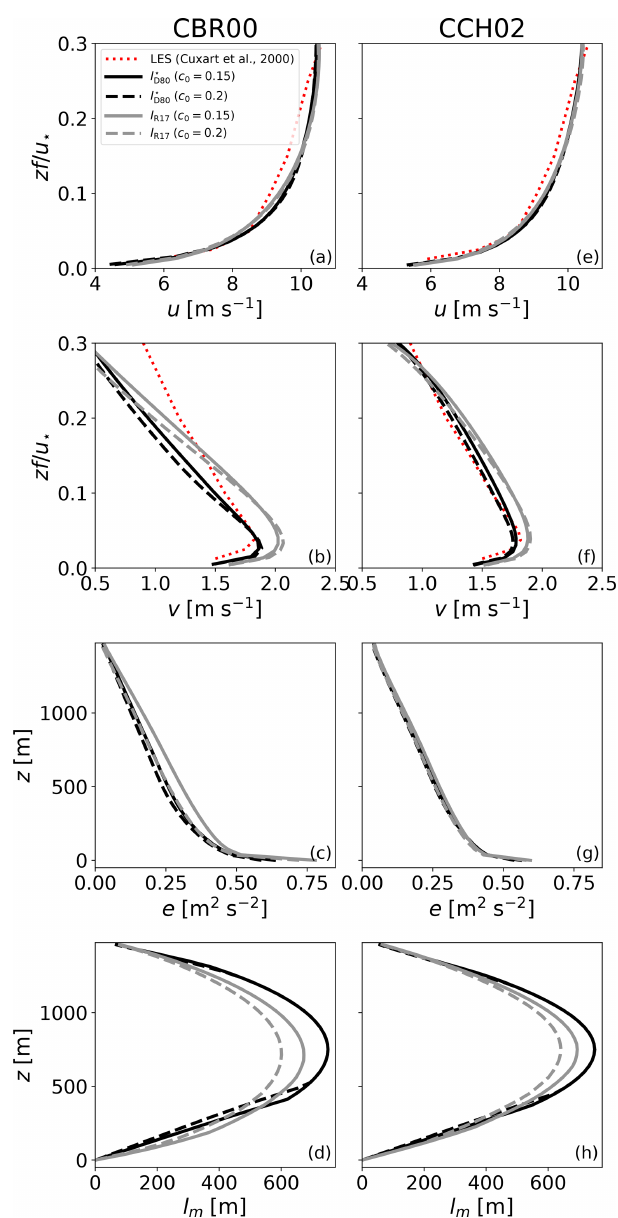
Figure 4. Results obtained for the neutral boundary-layer case of Andren et al. (1994) with the CBR00 model constants (left panels, a to d ) and CCH02 model constants (right panels, d to e ) for different parameter values for c 0 and different mixing-length formulations ( l (cid:63) for black lines or l R17 for gray lines). Results are shown for u D80 (a, e) , v (b, f) , e (c, g) , and l m (d, h) . In the top four panels results are compared with LESs from Cuxart et al. (2000) (their Fig. 16). As in Andren et al. (1994), simulations were run over a period of 10 /f and results are averaged over the last 3 /f period.